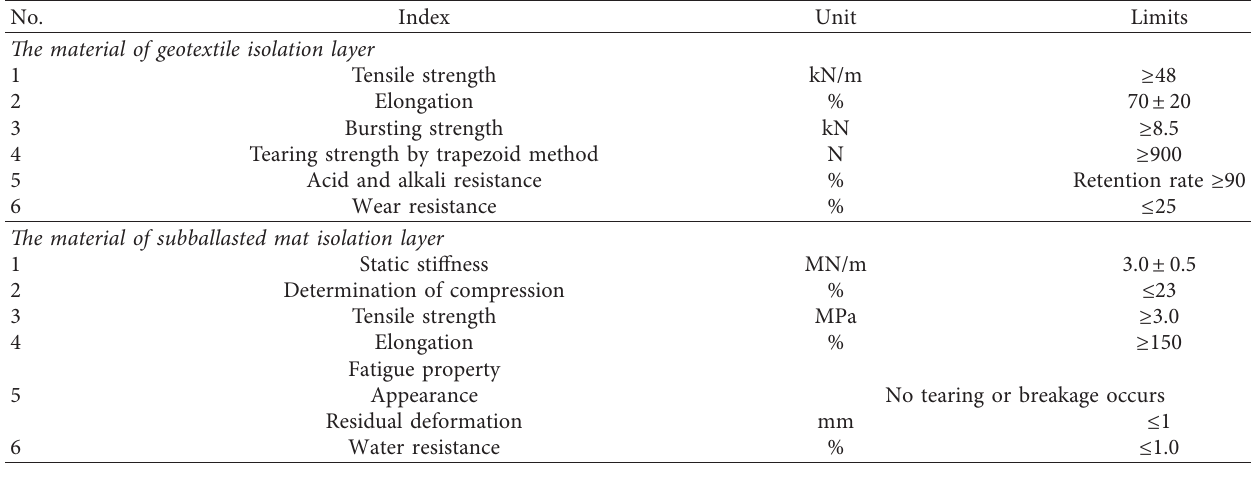
Table 2: The main parameters of two types of isolation layers in this work.